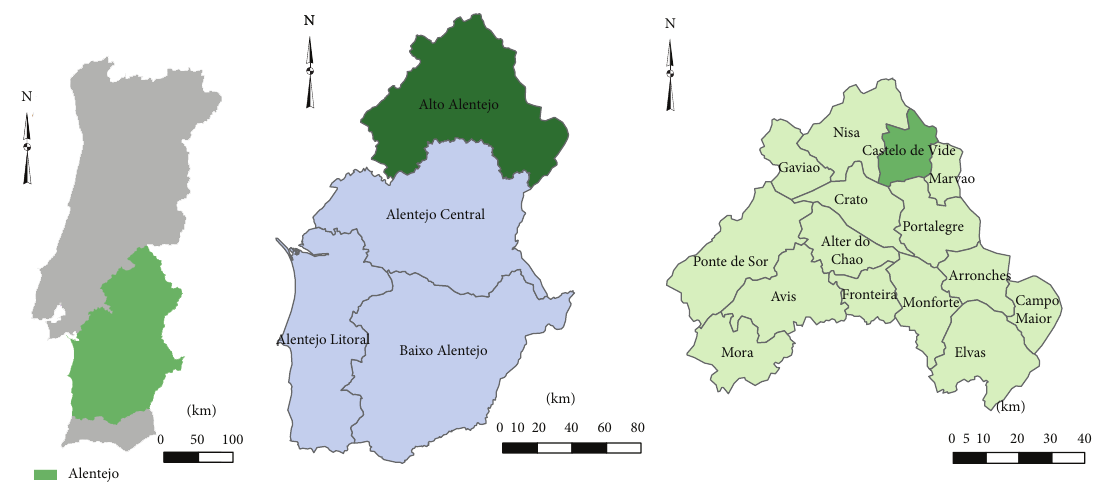
Figure 1: The model’s application